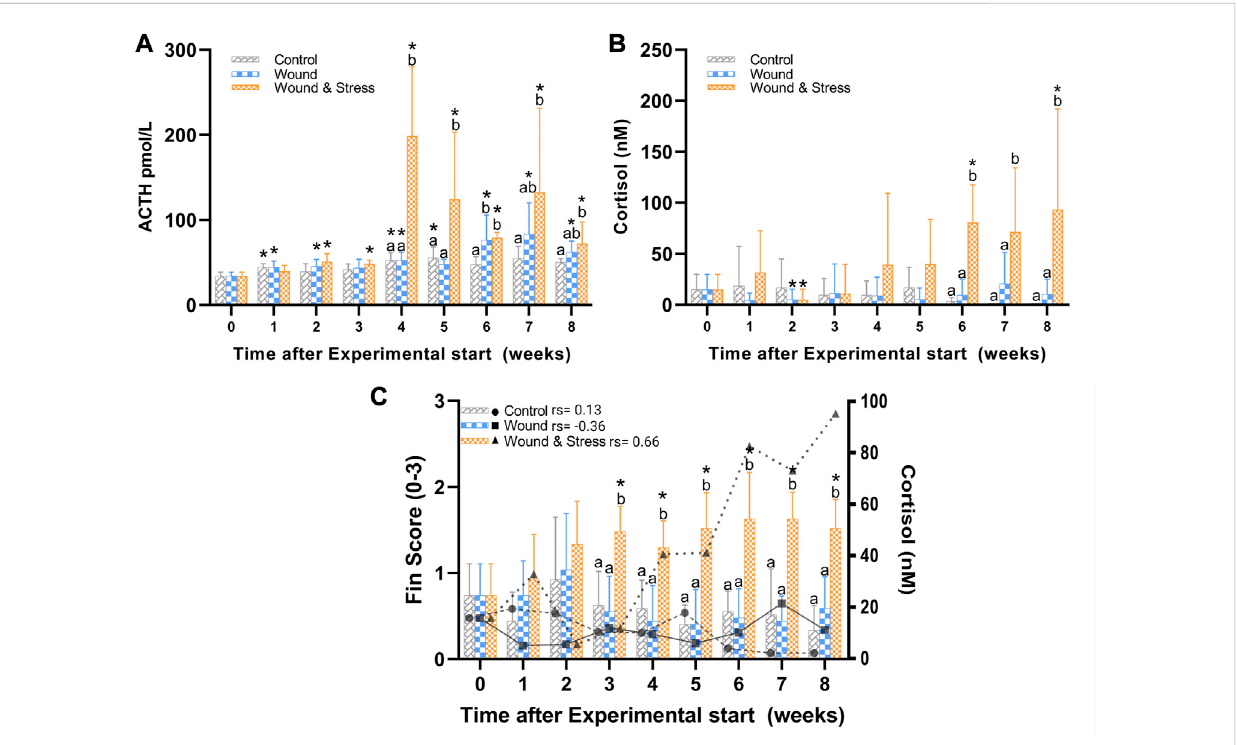
FIGURE 4 The average (±SD) changes in plasma ACTH (A) , cortisol (B) , and a combined average of pelvic, pectoral, and anal fi n erosion scores with an overlay of cortisol (C) in the control, wound, and wound + stress group (n = 9) during an 8-week experimental time. * Indicates a signi fi cant difference ( p < 0.05) from each group to the pre-stress value and letters a-b represent thesigni fi cant difference ( p < 0.05) within a single time point for all three groups where sharing letters means no signi fi cance between the groups. In (C) the individual rho or rs is represented in terms of a Spearman ’ s rank correlation coef fi cient indicated next to the group